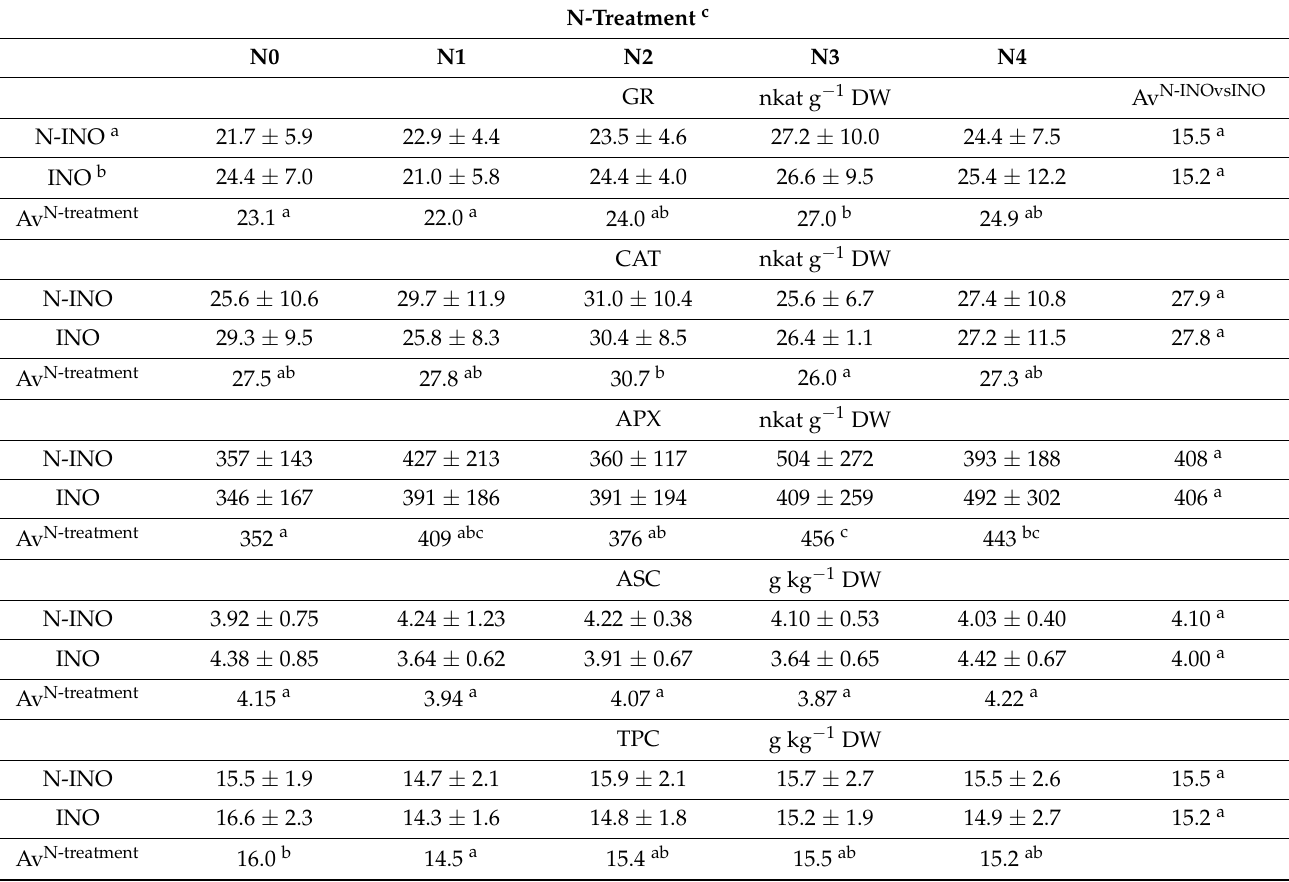
Table 2. Apple peel antioxidant status: N-fertilization and bacterial–fungal inoculation effects. N-Treatment